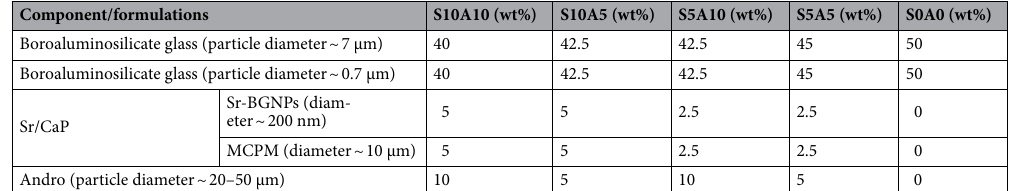
Table 1. Formulations of the experimental orthodontic